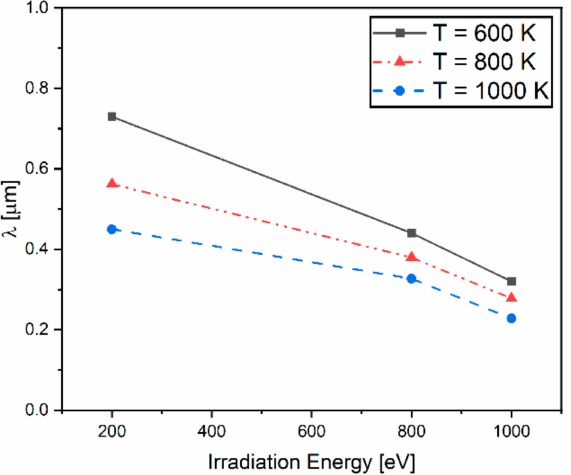
Figure 8. The effect of irradiation and temperature on the width of void denuded zone ( λ